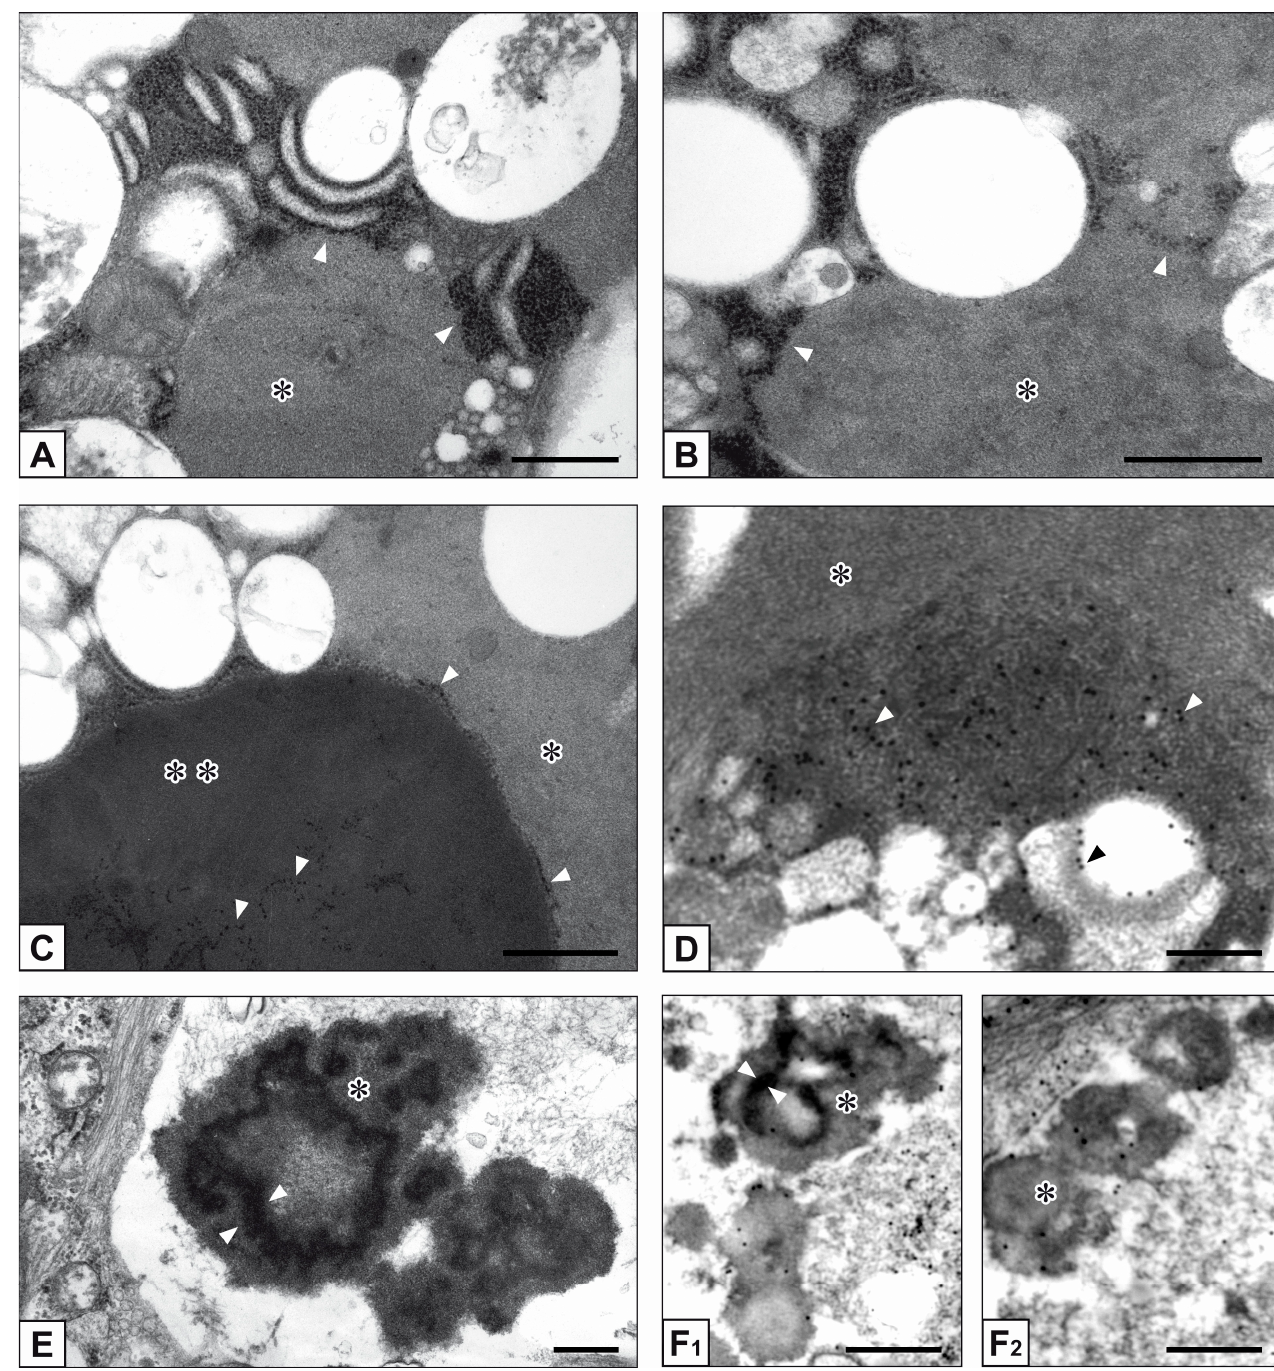
Figure 2. Ultrastructure of bAVICs from 15-day-long pro-calcific cultures. ( A – C ) Enlargement of RER cisternae (arrowheads) and RER membrane lysis, with ribosome release and merging with the nearby phthalocyanine-positive material (single asterisk: less condensed PPM; double asterisk: more condensed PPM) derived from ongoing membranous organelle degeneration. ( D ) Immunogold labelling of rRNA with gold particles (white arrowheads) decorating the intracellular PPM (asterisk) and a cross-sectioned degenerating RER cisterna (black arrowhead). ( E ) Cell-derived byproducts showing a mix of PPM (asterisk) and more electrondense phthalocyanine-positive layers (PPLs; counterposed arrowheads). ( F 1 , F 2 ) Immunogold labelling of rRNA showing gold particles within PPM (asterisks) and PPLs (counterposed arrowheads) at the level of vesicular cell debris. Bar: 0.5 μ m ( A – C , E ); 0.25 μ m ( D , F 1 , F 2 ).